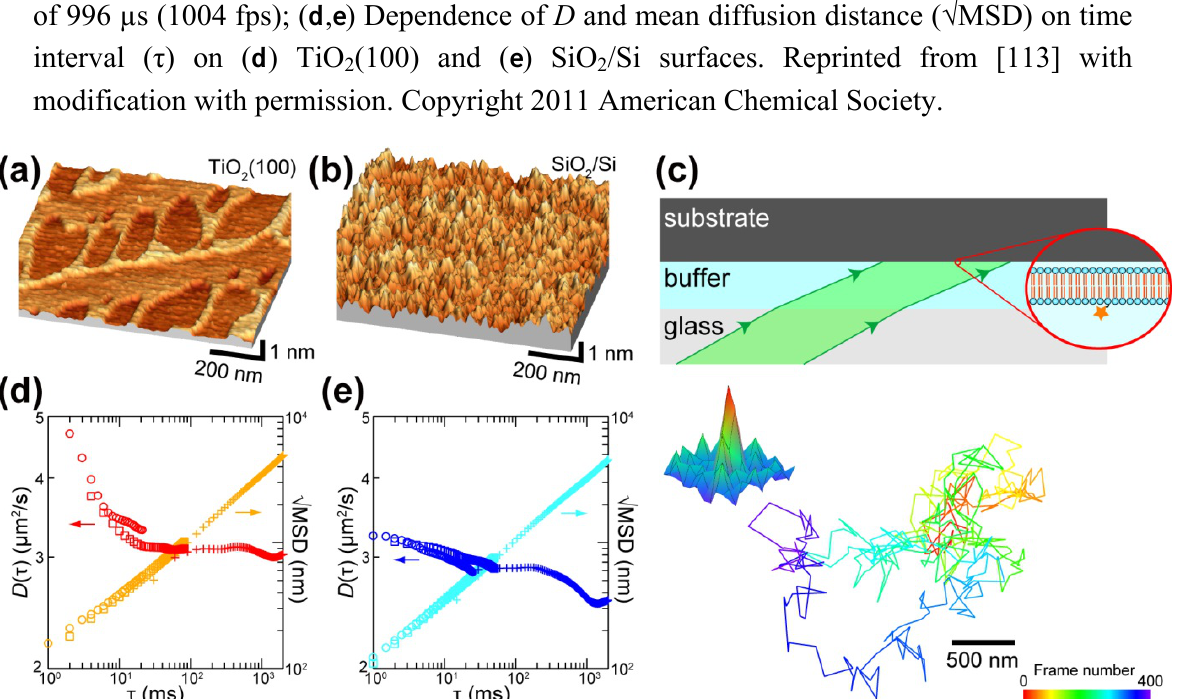
Figure 4. ( a , b ) AFM topographies of ( a ) step-and-terrace TiO